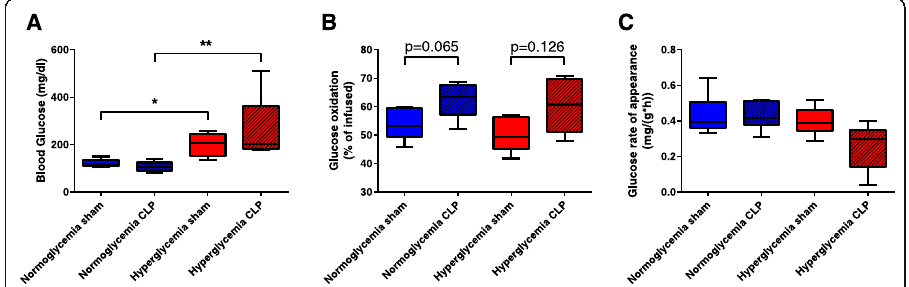
Fig. 1 Glucose utilization during ICU (intensive care unit) treatment. a Blood glucose levels at 5 h of ICU, * p ≤ 0.05, ** p ≤ 0.01. b Glucose oxidation (percentage of oxidized tracer) at 4 h of ICU. c Glucose rate of appearance at 5 h of ICU. All data is presented as median (interquartile range). Kruskal-Wallis analysis of